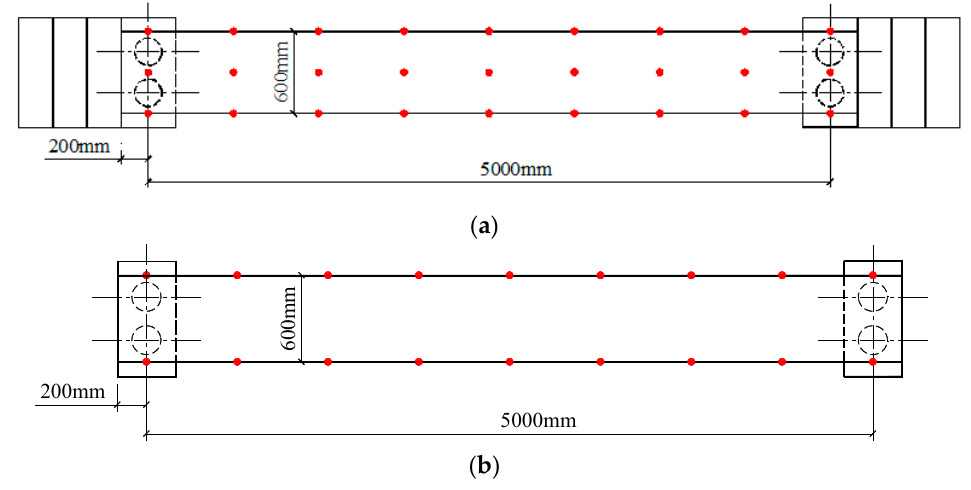
Figure 2. Locations of temperature measurement points. ( a ) Top surface. ( b ) Bottom surface.